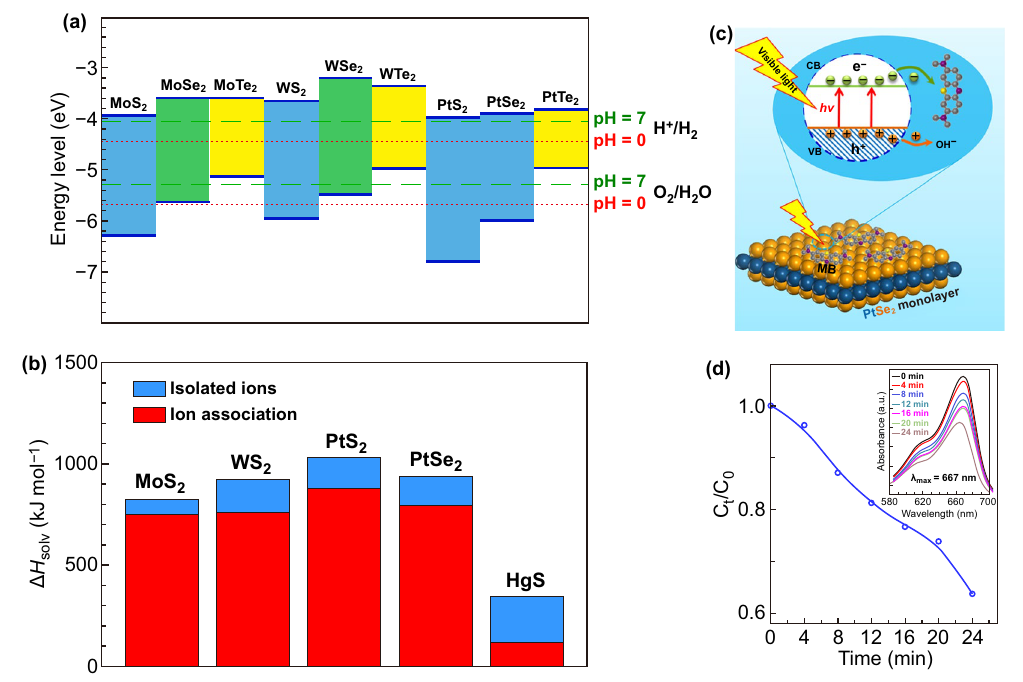
Fig. 13 Photocatalytic properties of PtSe 2 . a CBM and VBM edge positions of monolayer TMDCs relative to the vacuum. b Comparison of the calculated solvation enthalpies (ΔHS olv ) of monolayer PtSe 2 , PtS 2 , MoS 2 , and WS 2 to the value of HgS. The ΔHS olv of insoluble HgS is shown for comparison which shows a negligible solubility of 1.27 × 10 −27 mol/100 g of H 2 O. Reproduced with permission [40]. Copyright 2019, American Chemical Society. c Schematic diagram of the photocatalytic degradation mechanism of methylene blue (MB) molecular over PtSe 2 film. d Relationship between C t /C 0 and the photocatalytic degradation time under visible light ( C t and C 0 are the MB concentrations at time t and 0 min). The inset shows the UV–Vis absorption spectra of MB solution for every 4 min. Reproduced with permission [25]. Copyright 2015, American Chemical